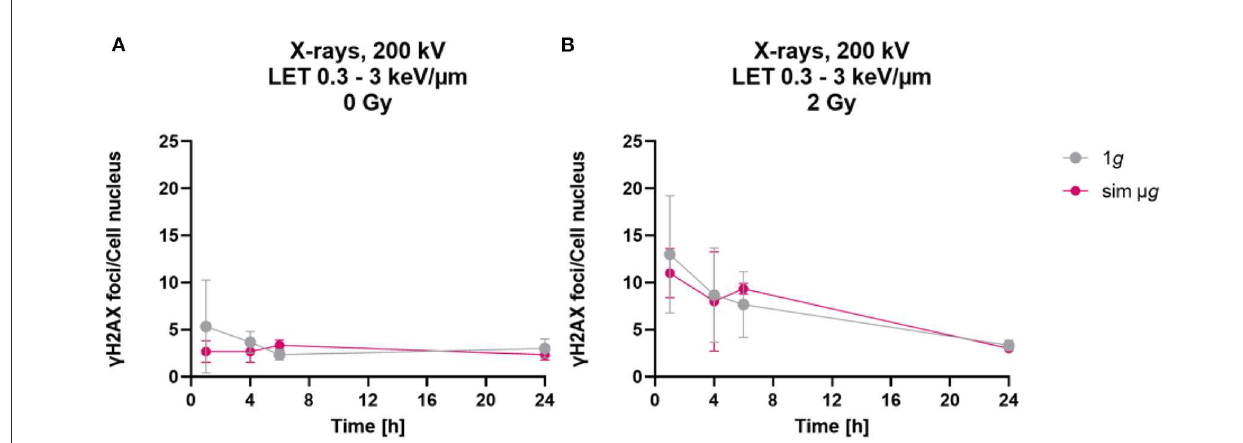
FIGURE4 Simulated “space conditions” using simulated microgravity combined with X-irradiation did not influence repair of DNA double strand breaks. The number of γ H2AX foci per cell of unirradiated (A) or X-irradiated (2Gy) (B) astrocytes exposed after irradiation to either simulated microgravity (sim µ g ) by fast 2D clinorotation at 60 rpm or at normal 1 g gravity conditions. The samples were compared via two-way-ANOVA ( n = 3, p < 0.05). Data are shown as represent mean ± SD.